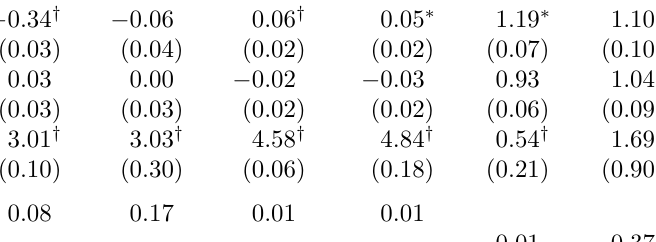
Panel A: Additive and Interactive